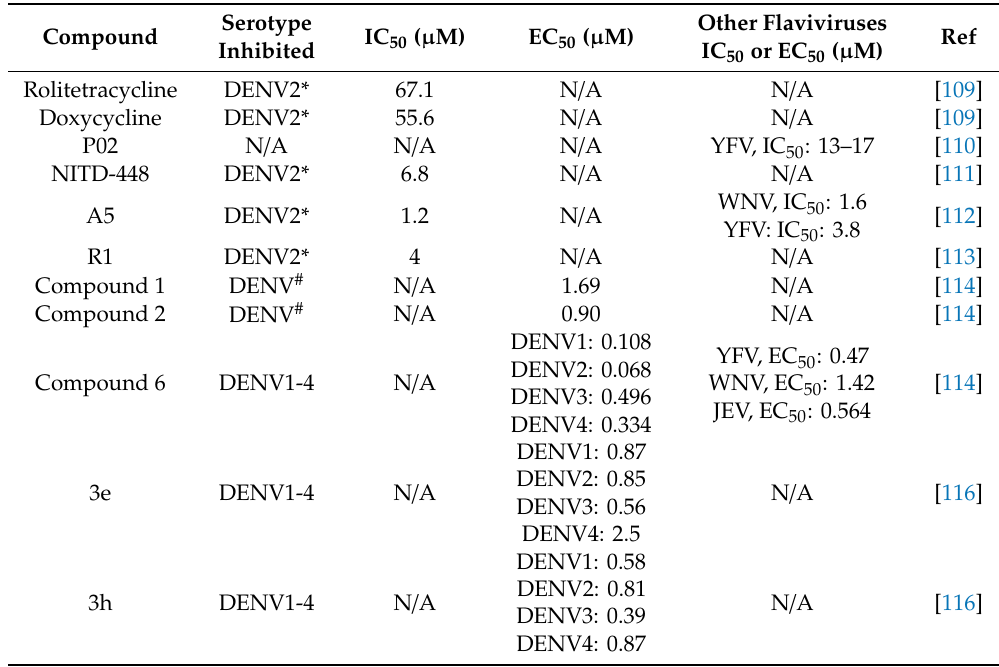
Table 2. Antiviral compounds targeting the E